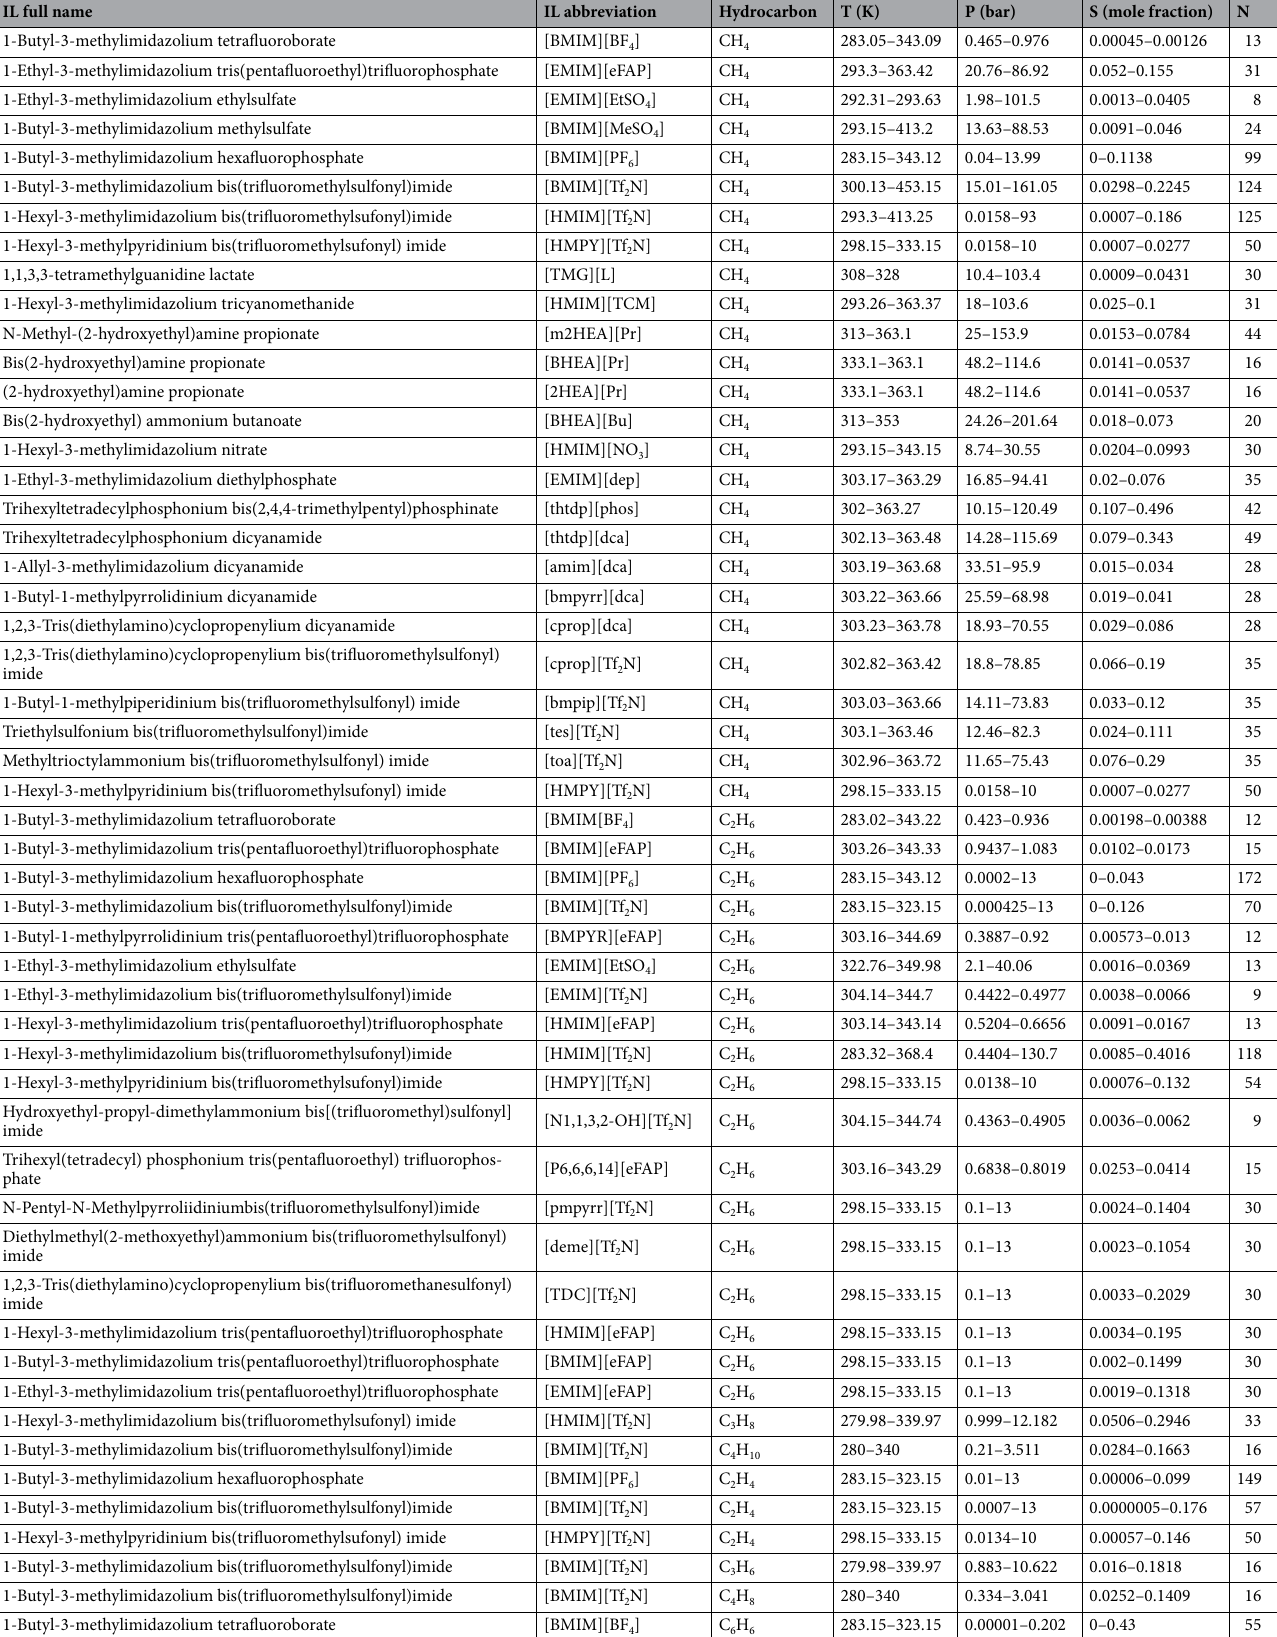
Table 1. Description of systems of ionic liquids and hydrocarbons used in this